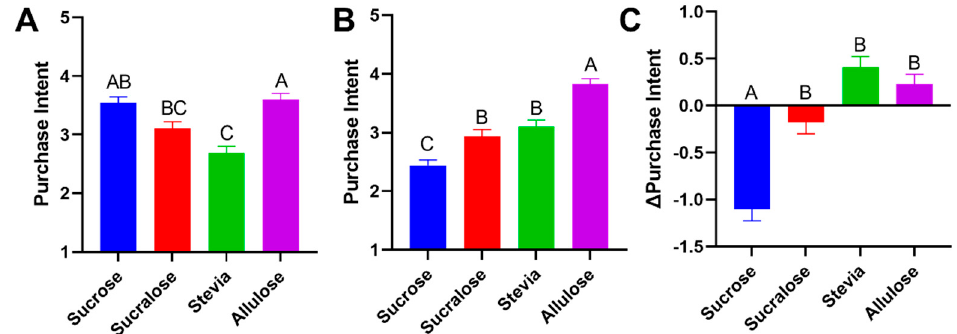
Figure 4. Purchase intent. Purchase intent (5-point scale) for the samples was compiled with data corresponding to before ( A ) and after ( B ) providing information about the sweeteners to participants, as well as the difference between before and after, presumably arising from this information ( C ). In the scoring process, 1 = Definitely would not purchase, 2 = Probably would not purchase, 3 = May or may not purchase, 4 = Probably would purchase, 5 = Definitely would purchase. Bars show mean and SEM, different letters denote statistical differences.